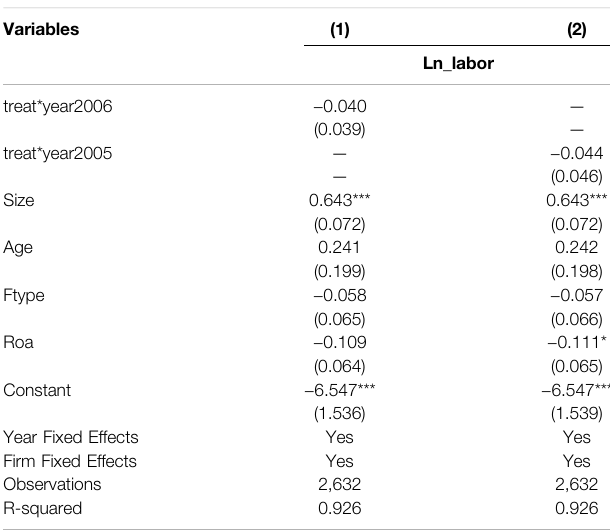
TABLE 4 | Counterfactual test.